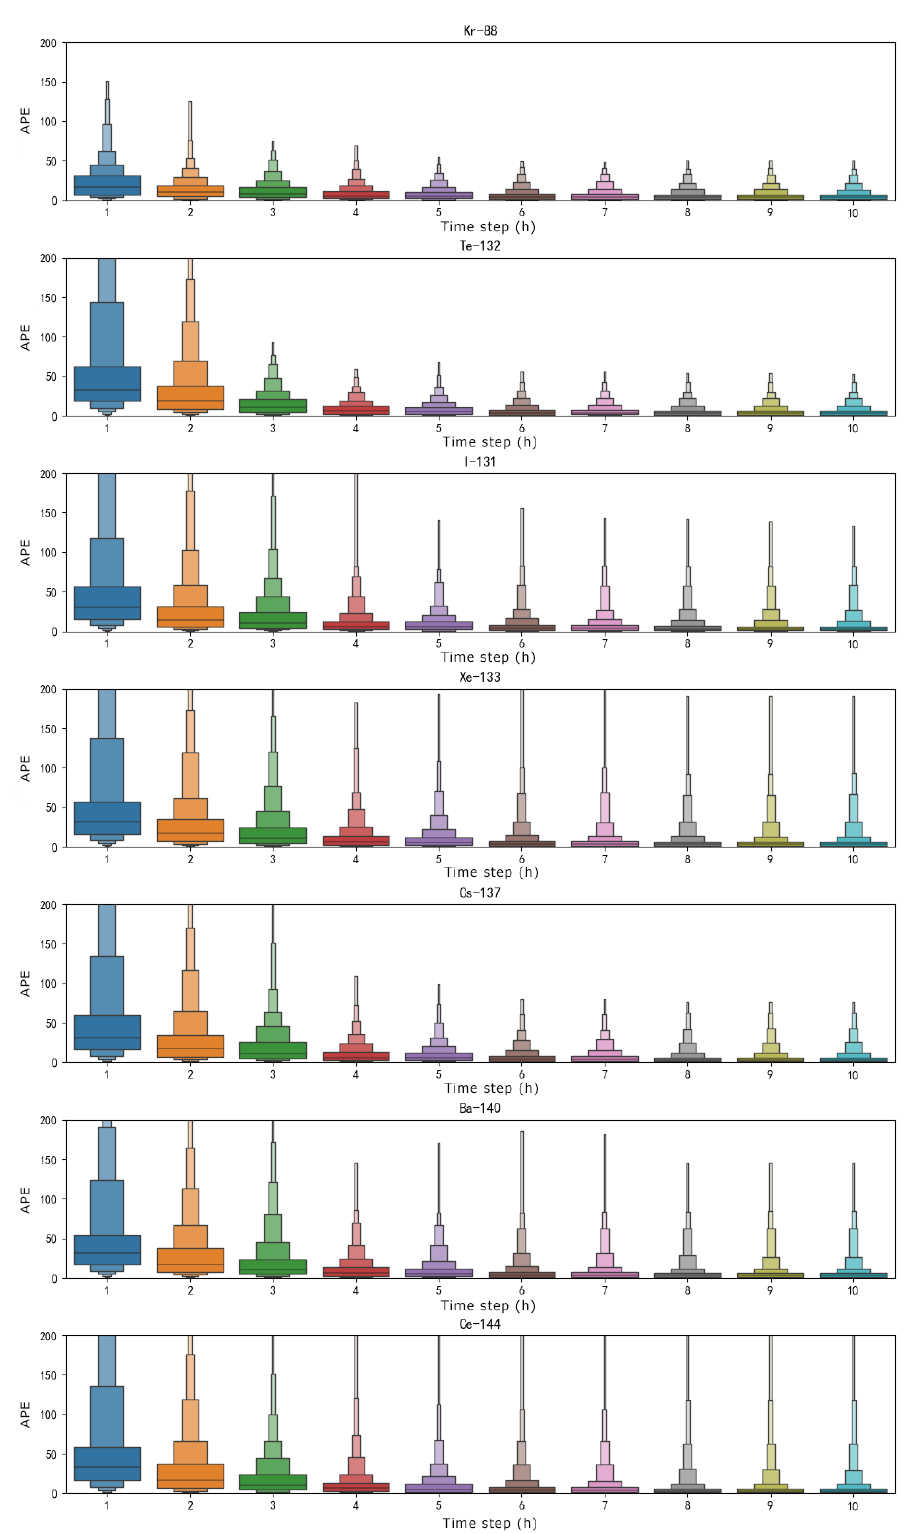
Figure 12. Distribution of absolute percentage error (APE) of the fusion model for all predicted values of different nuclide release rates in the test dataset.